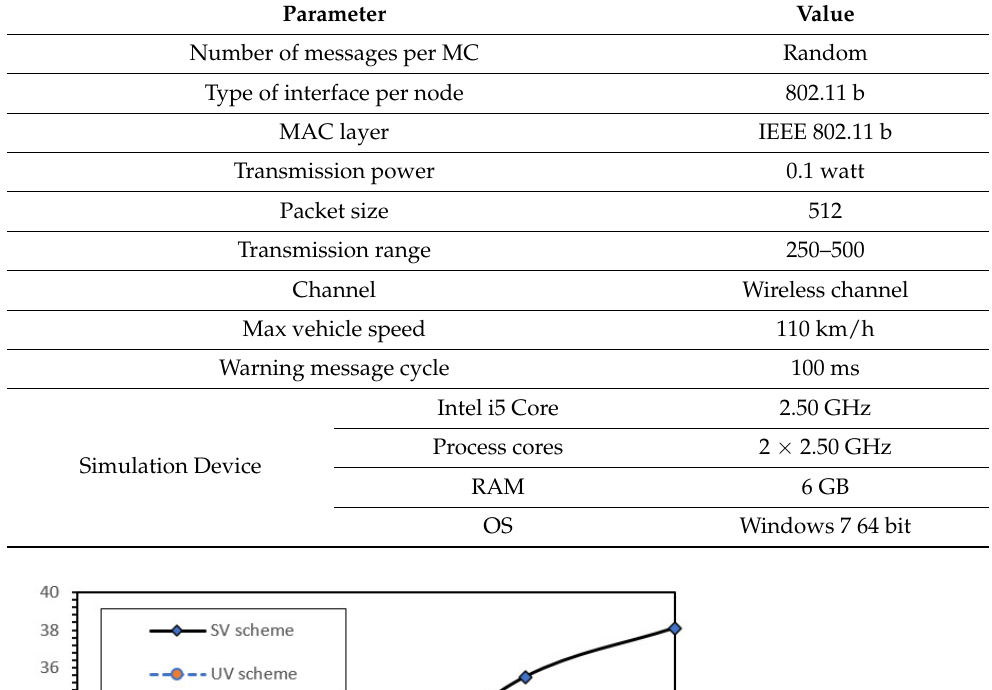
Table 1. Simulation Parameters.